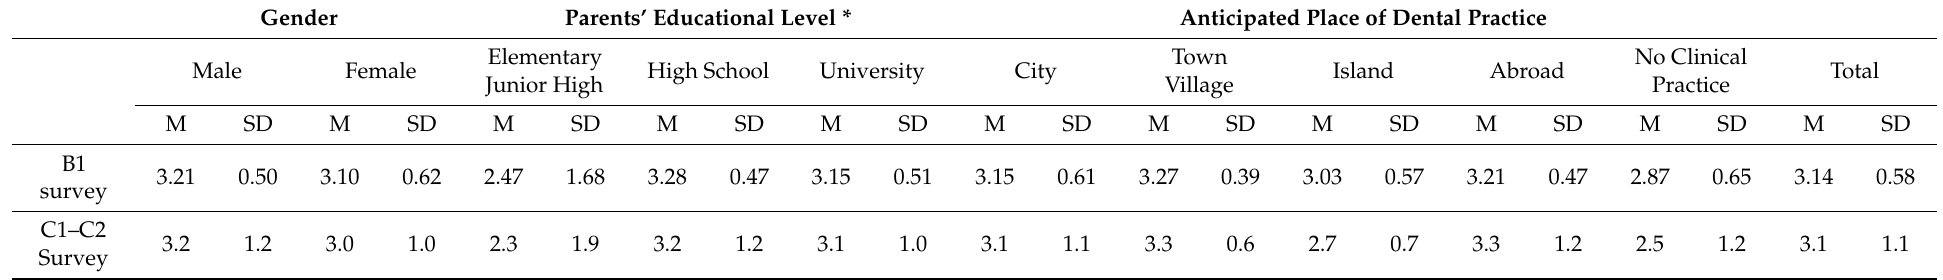
Table 1. Bivariate (ANOVA) and linear regression analysis of the total mean scores (M) and standard deviations (SD) of the DSC questionnaire by gender, parent’s educational level and anticipated place of practice of